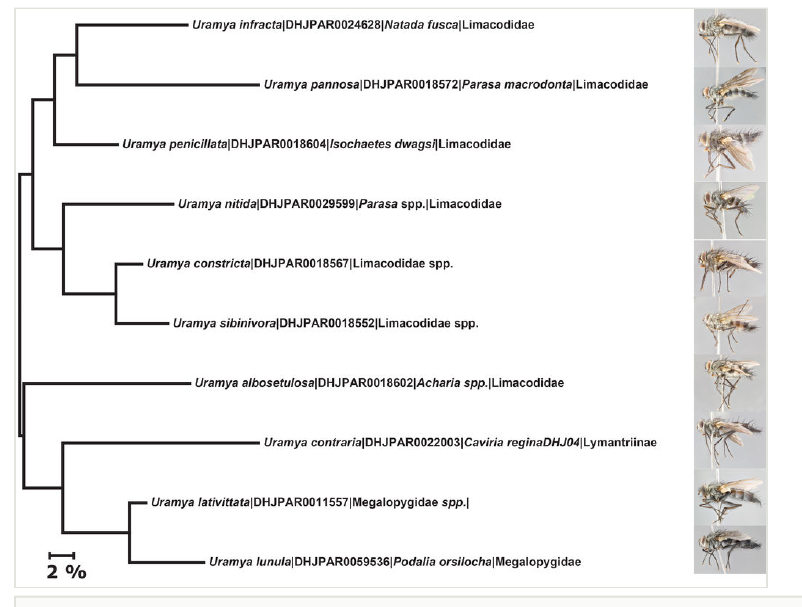
Neighbor Joining tree (NJ – Saitou and Nei 1987) comparing the species of Uramya present in ACG. Tree based on the Kimura-2-parameter (Kimura 1980) made using MEGA6 (Tamura et al. 2013) for a single specimen from each of the Uramya species discussed here. Tip labels include: species name|sample accession|species parasitized|family of parasitized caterpillar, and the image of a male in lateral view. Each sample presented here is the holotype for the species described here, except U. sibinivora. This phenogram shows the low intra-speci fi c and high inter-speci fi c variation of CO1 barcode